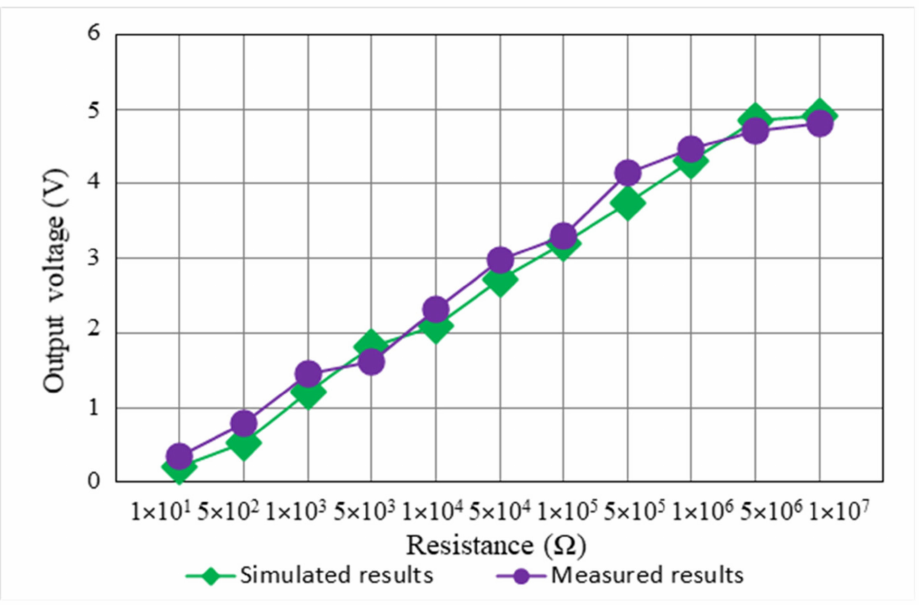
Figure 20. Simulated and measured output DC voltage versus the load resistance for the proposed design.